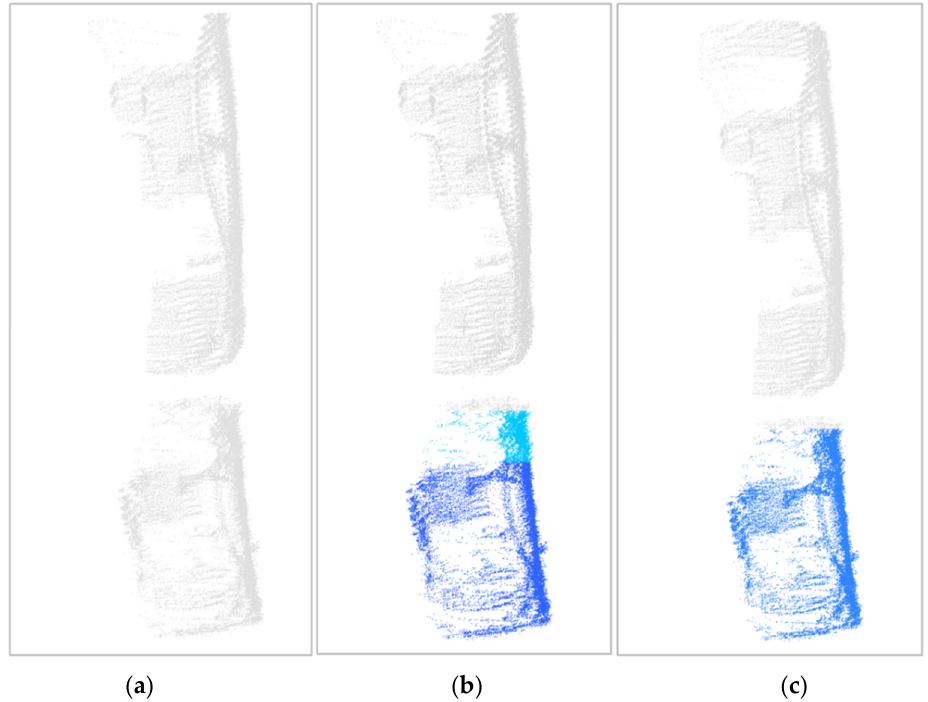
Figure 18. An example of neighborhood splitting and merging effect. Neighborhood segmentation result by region growth based relative tension ( a ); on the basis of the result in ( a ), neighborhood splitting result ( b ); on the basis of the result in ( b ), neighborhood merging result ( c ). Note: Different neighborhoods are displayed in different colors.